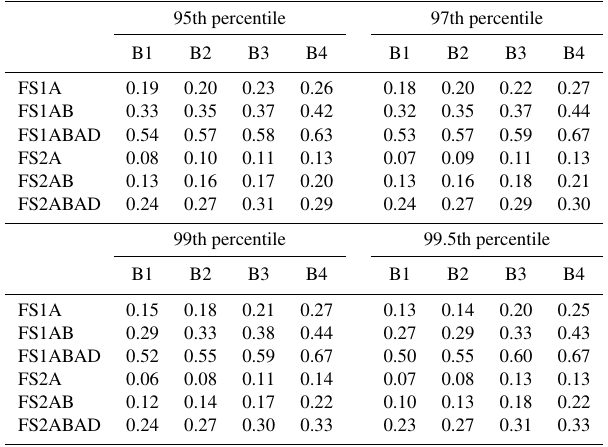
Table 3. Average duration in days of a flood event belonging to the different groups and extracted above the different